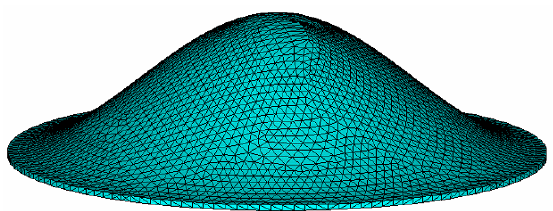
Figure 4. The finite element model of the bionic structure of the tympanic membrane. Table 2. The material properties of polysilicon at 300 K